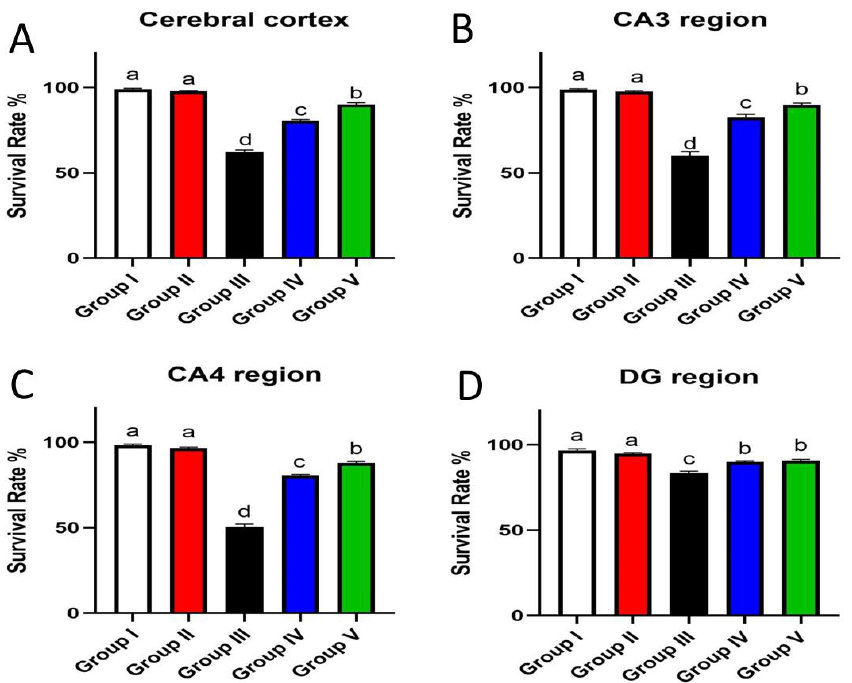
Figure 11. Effect of administration of umuhengerin on neuronal survival rate. Neuronal survival rate of different experimental groups was estimated in ( A ) the cerebral cortex, ( B ) CA3, ( C ) CA4, and ( D ) DG regions. Group I (control), group II (umuhengerin), group III (STZ), group IV (STZ + umuhengerin), and group V (STZ + donepezil). Values are expressed as mean ± SEM; n = 3. Different letters (a–d) above the error bar indicate statistically significant differences at p < 0.05 .